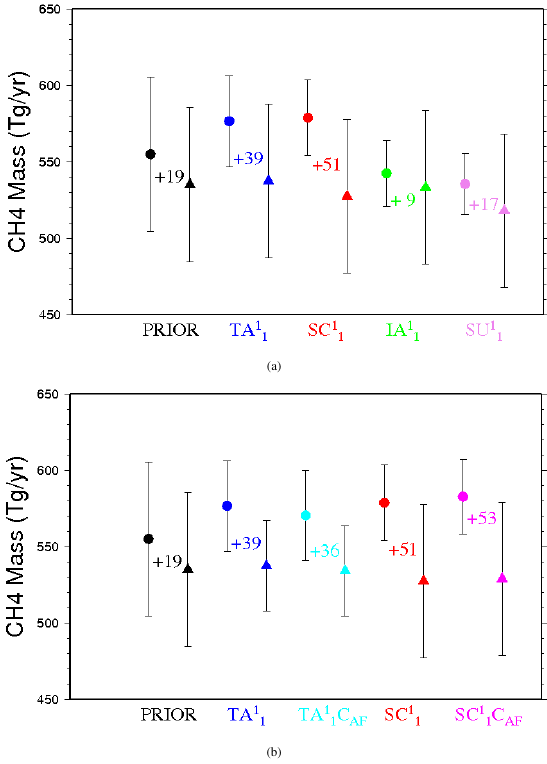
Fig. 3. Global emissions (circles) and losses (triangles) for the configurations TA 1 1 (blue), SC 1 1 (red), IA 1 1 (green) and SU 1 1 (violet) (a) and for TA 1 1 (dark blue), SC 1 1 (red) and bias-corrected configurations TA 1 1 C AF (light blue) and SC 1 1 C AF (magenta) (b). Numbers describe the global growth rates in Tg yr − 1 inferred by the inversions. Error bars represent the posterior uncertainties estimated with the Monte-Carlo study (see Section 2.1).